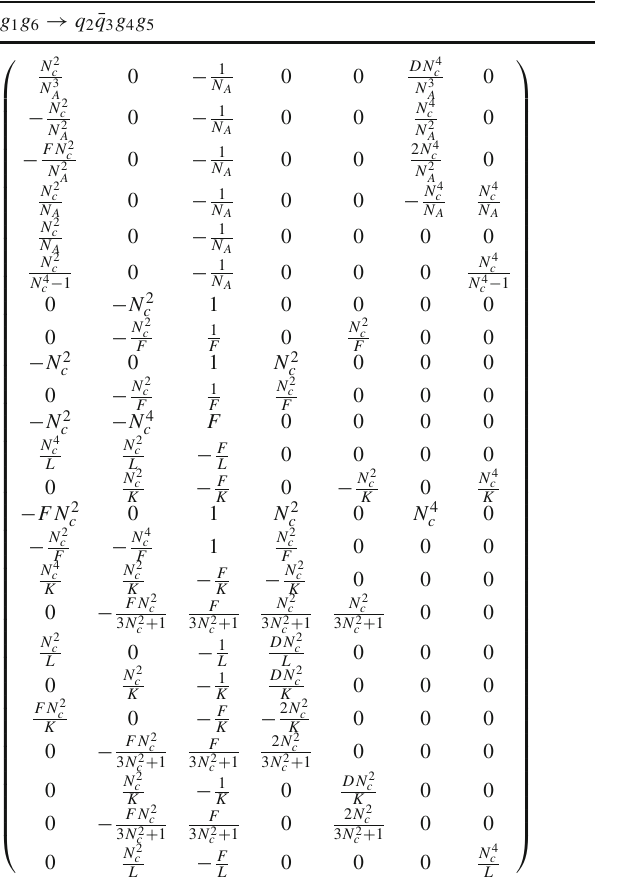
Table 10 Matrices M of structures appearing in the six-parton pro- cesses (part III) ( D = N 2 c − 2, F = N 2 c + 1, K = N 4 c − 2 N 2 c − 1, L = N 4 c − N 2 c − 1). The subscripts in the sub-process indication cor- respond to the momenta enumeration